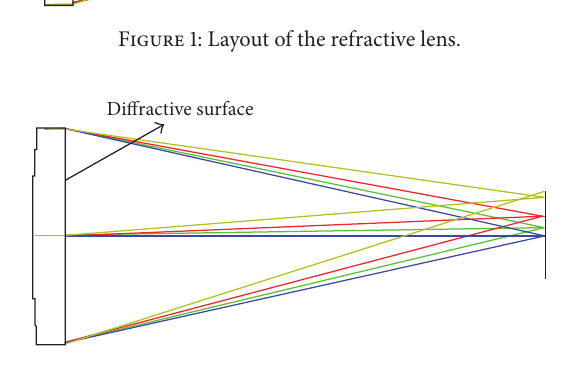
Figure 2: Layout of the diffractive lens.